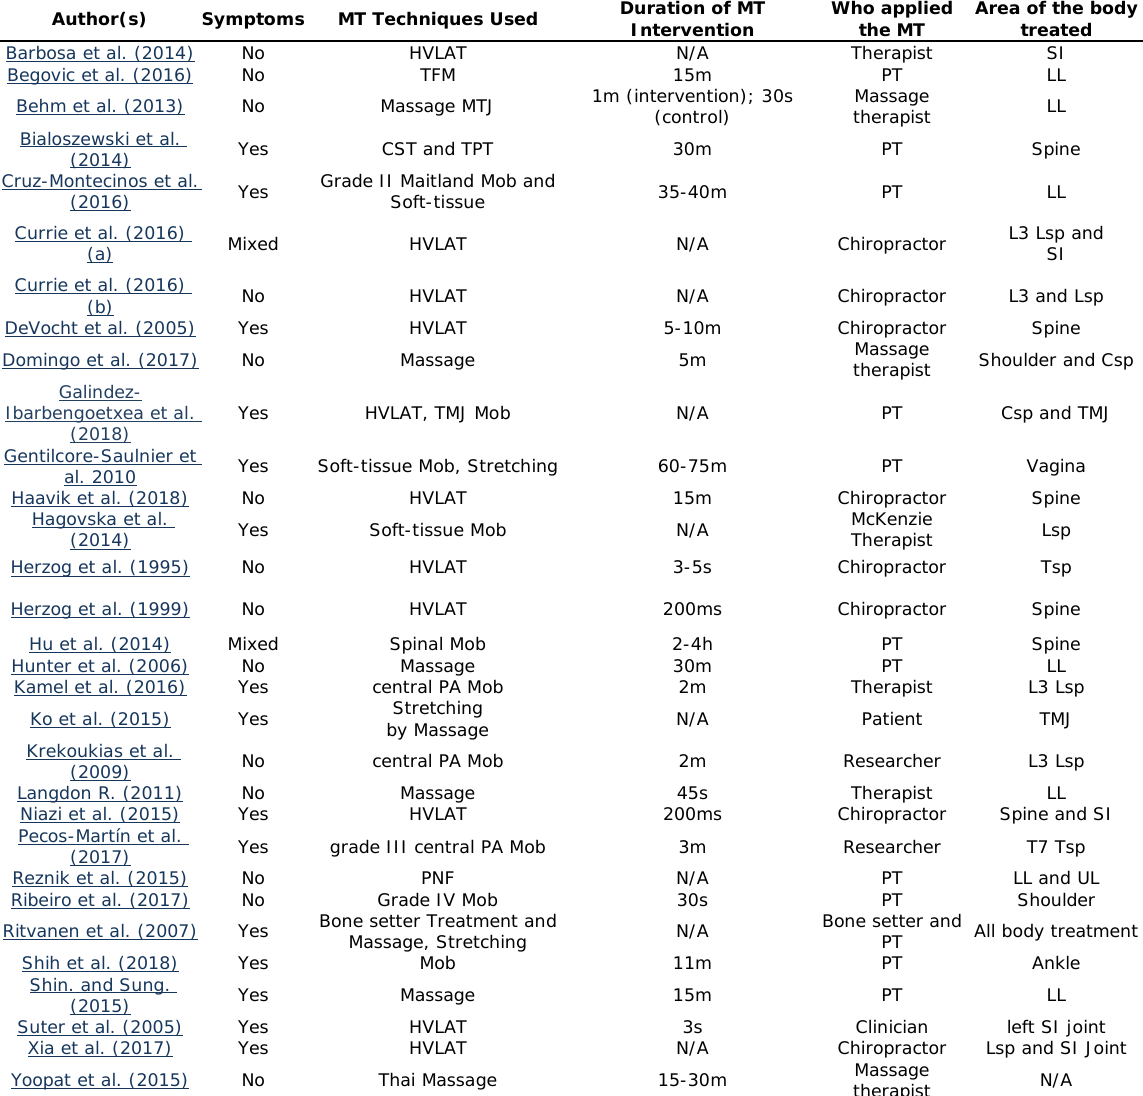
Table 3. Use of sEMG in Manual Therapy: